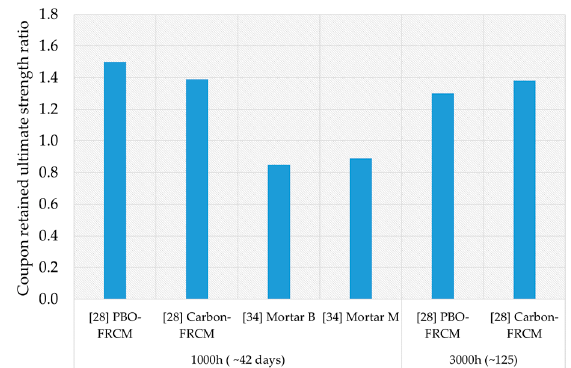
Figure 9. Effect of immersion in saline solutions on the retained ultimate strength ratio of fabric-reinforced cementitious matrix (FRCM) coupons.